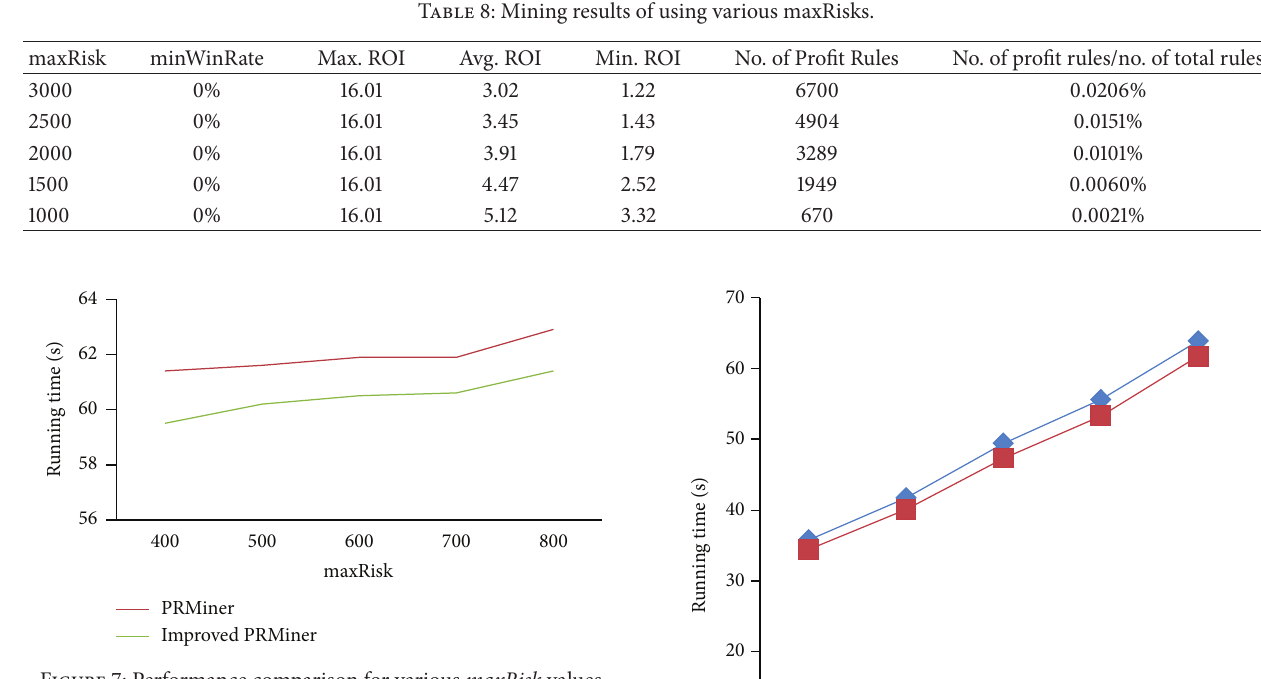
Figure 7: Performance comparison for various maxRisk values.